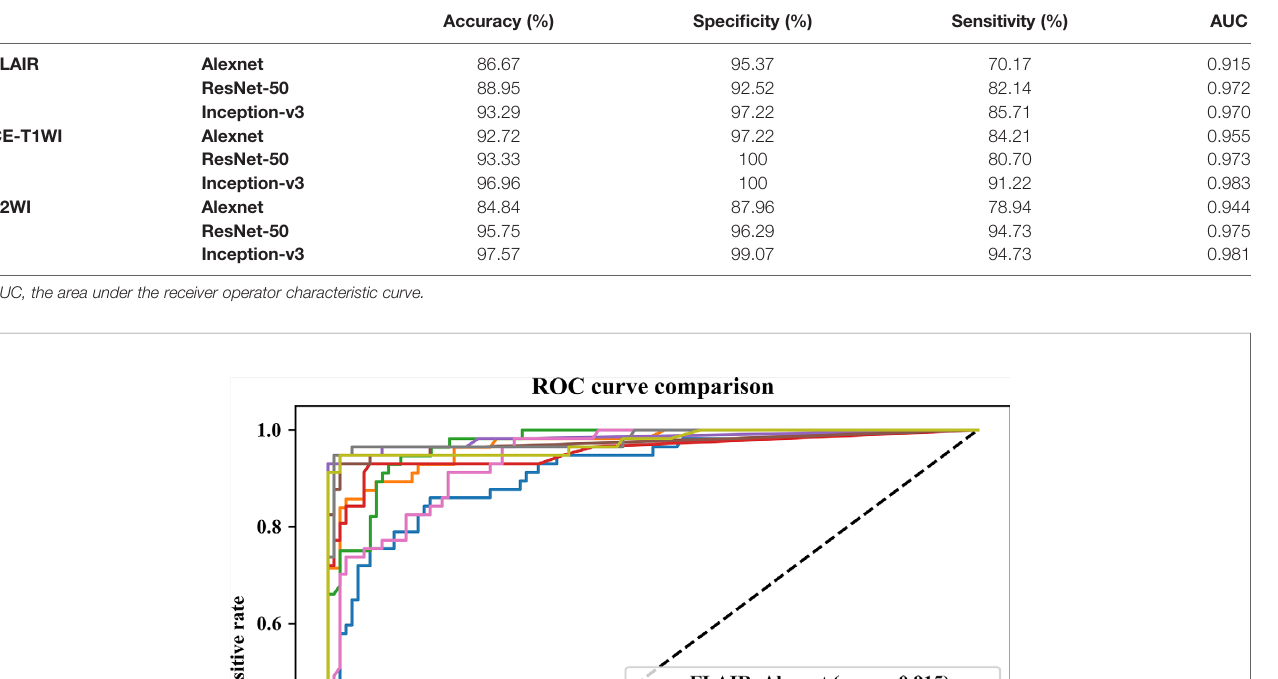
TABLE 1 | Performance comparison of three pretrained models based on three single MRI modalities.